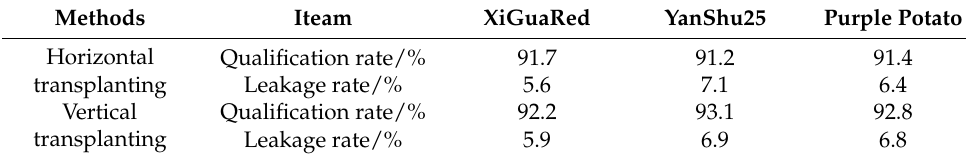
Table 5. Transplanting results at 0.20 m/s.